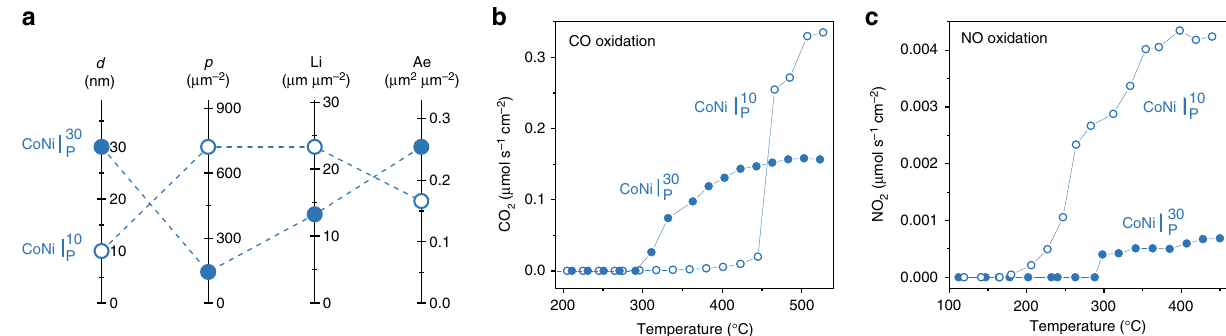
Fig. 4 The effect of particle characteristics on catalytic activity. a Initial particle characteristics for the model pellet catalysts with 10 and 30 nm particles presented as a parallel coordinate plot and including: particle diameter d , particle population p , length of the particle – perovskite interface Li and exposed particle area, Ae. b , c Corresponding catalytic activity after activation, for b CO oxidation and c NO oxidation. The catalytic rates are normalised with respect to the area of the pellet decorated with particles (Supplementary Note 3). The values of p , Li and Ae are normalised with respect to the area decorated with particles (given per μ m 2 ). The errors are smaller than (Supplementary Fig. 11), adjacent cubes merge (e.g. particles 15 and 19 in Fig. 2g – i), exposing empty sockets in the process (e.g.